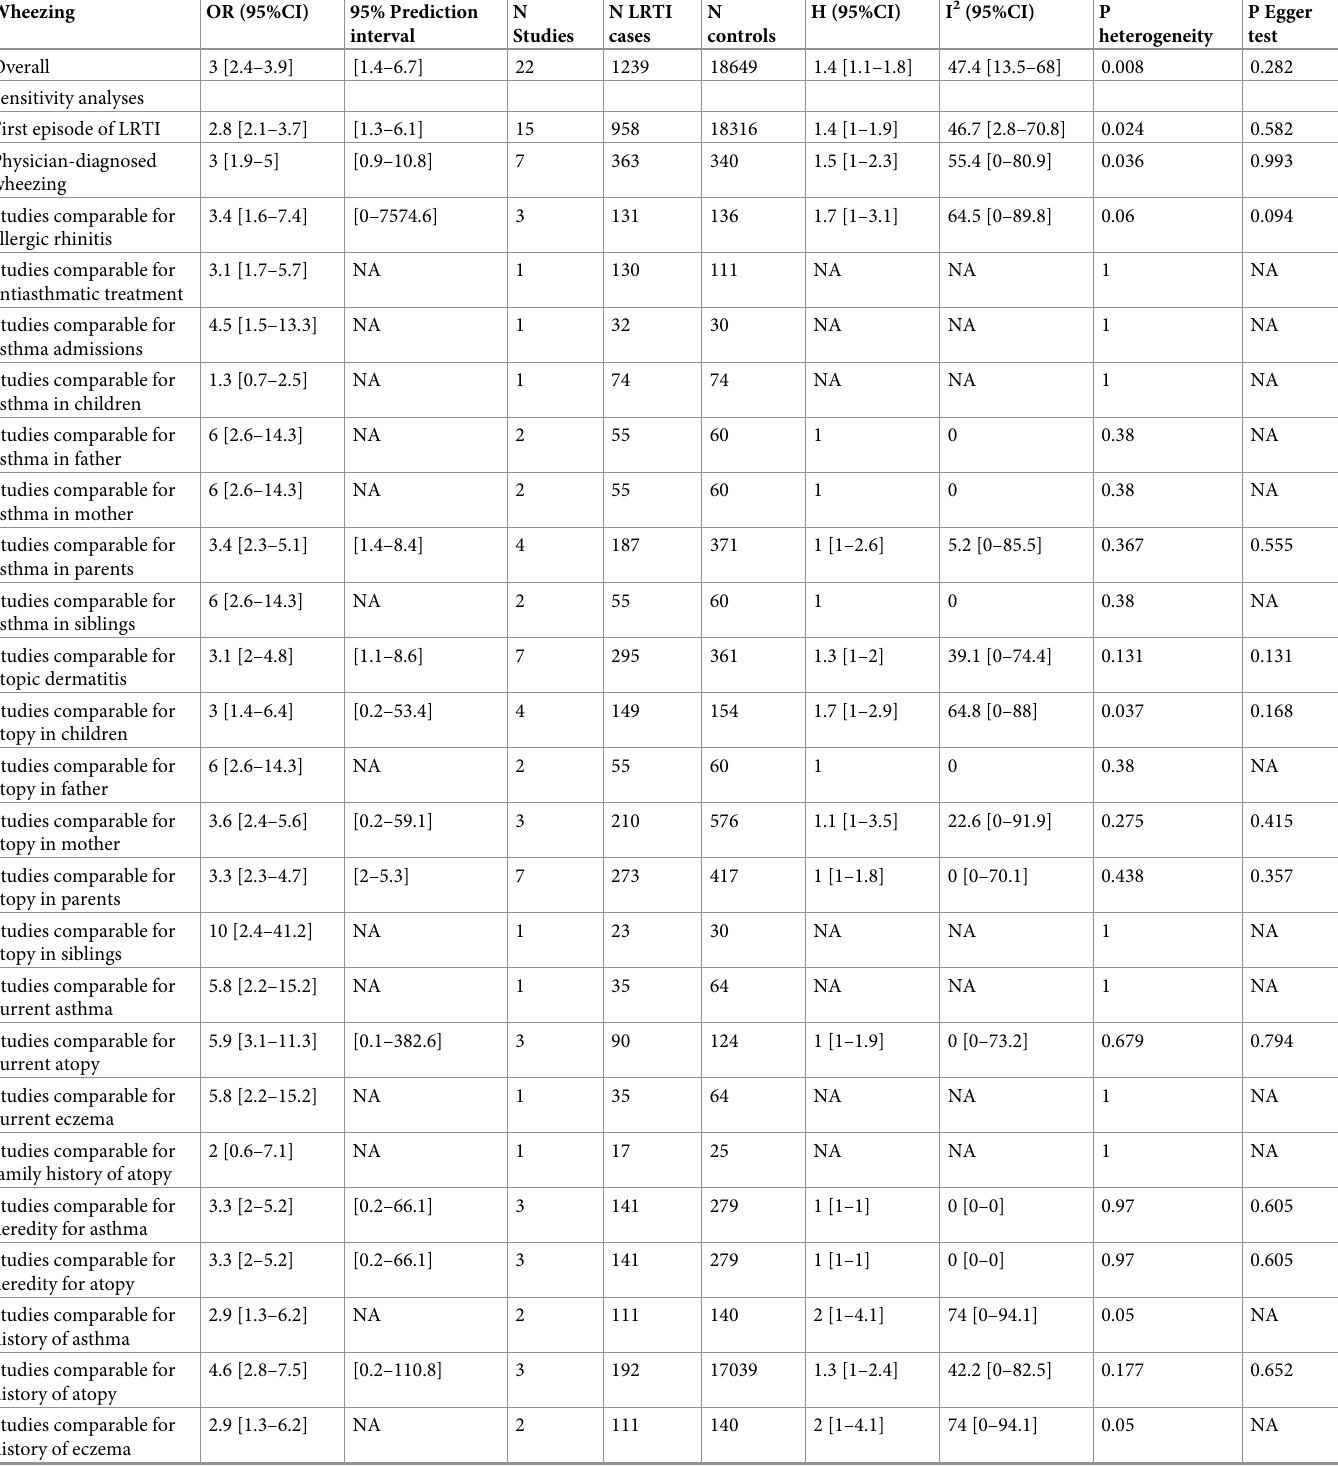
Table 1. Wheezing in children with LRTI in infancy and control without respiratory